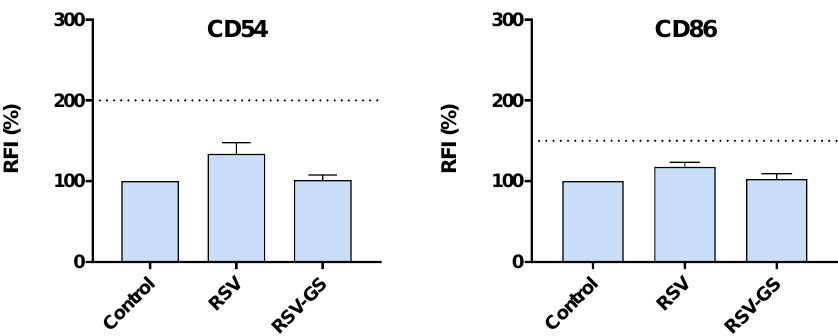
Figure 1. Skin sensitization potential of RSV and RSV-GS compounds. The relative fluorescence intensity (RFI) of CD54 and CD86 expression was measured. Bar graph presents the mean ± standard error of mean (SEM) of at least three independent experiments. Dashed line indicates the established thresholds for CD54 (200%) and CD86 (150%) markers. The comparisons were performed using one- way ANOVA analysis, with Dunnett’s multiple comparison post-test, where p < 0.05 was considered significant compared with the control.